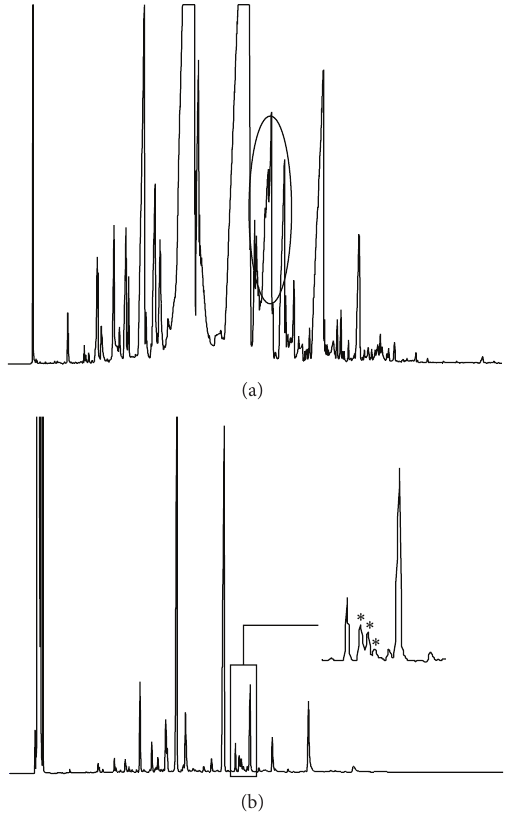
Figure 5: GC-FID chromatogram of A. judaica oil. ( ∗ ) peaks appeared as three peaks depicting the ability of FID detector in conserving the chromatographic separation in comparison with MS detector which possesses relatively higher dead